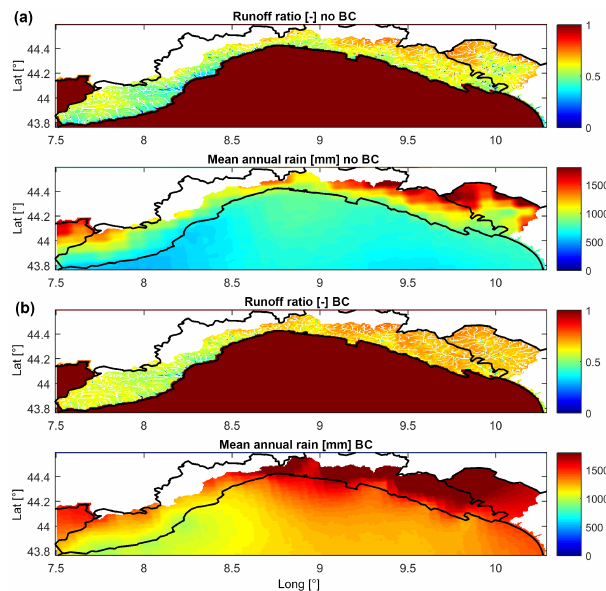
Figure 16. Distributed runoff ratio and mean annual rain- fall. (a) shows the model estimation without BC while (b) with